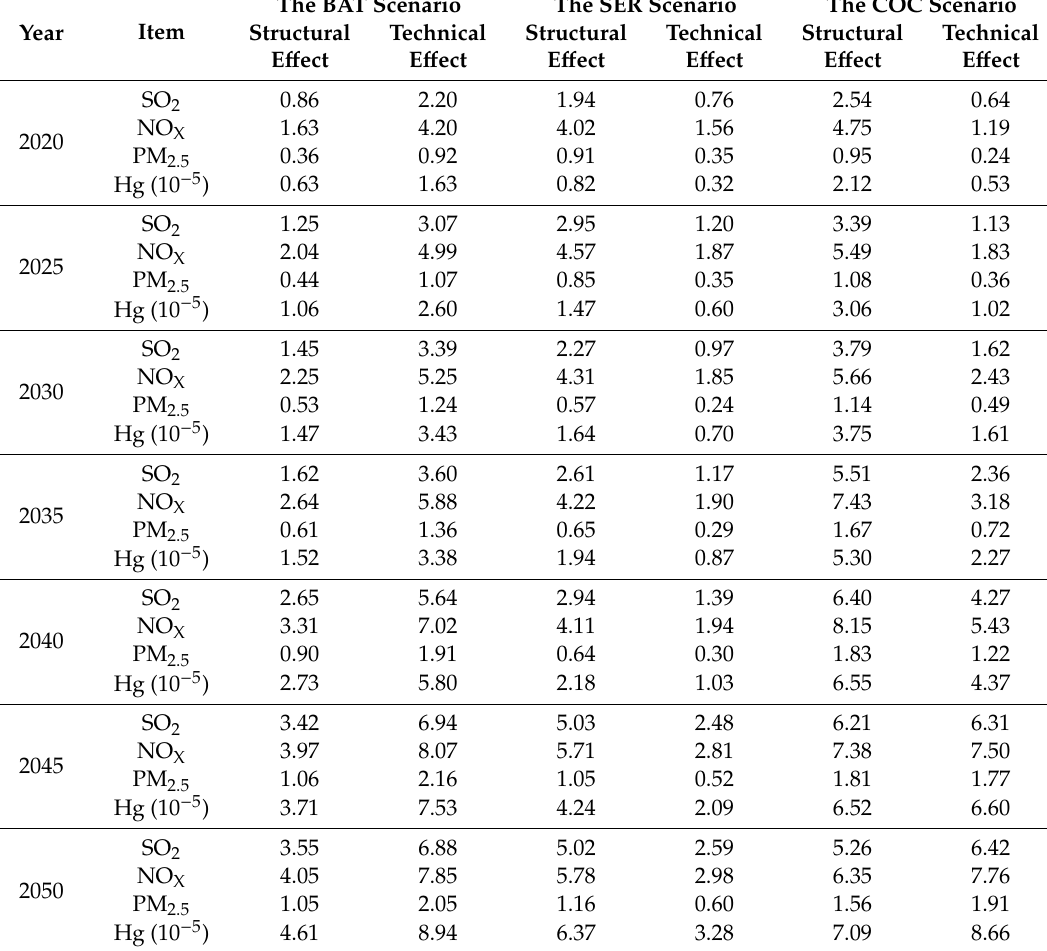
Table 6. Emission reduction e ff ect for the decomposition of air pollutants